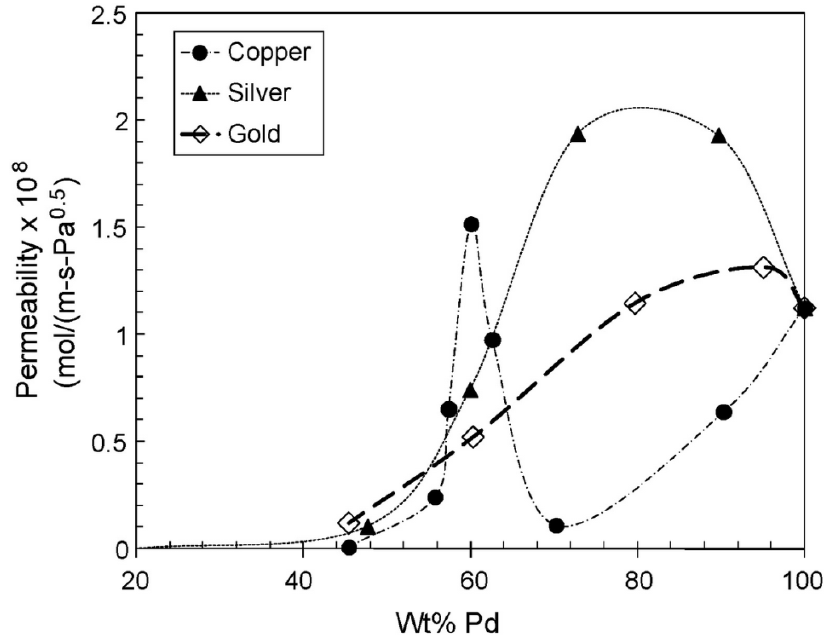
Figure 10. H 2 permeability at 350 °C for different Pd-based alloys containing Ag, Cu and Au [206] , with permission from © Elsevier.